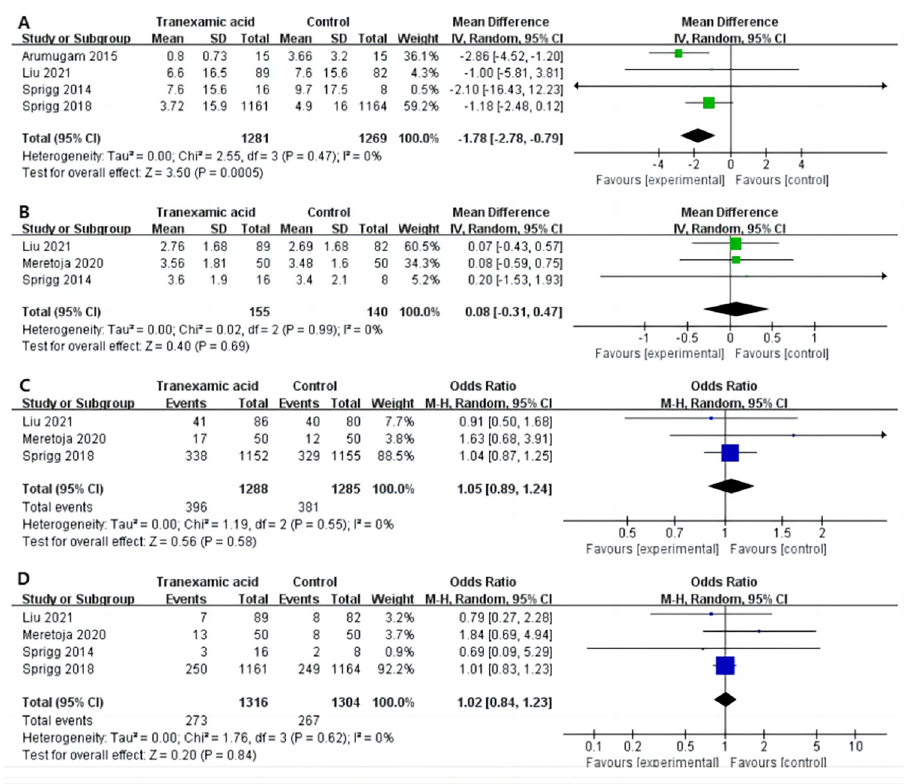
Fig 1. Forest plot of the effect of tranexamic acid on hematoma growth (A), mRS (B), mRS � 2 (C), and mortality (D) in patients with ICH.